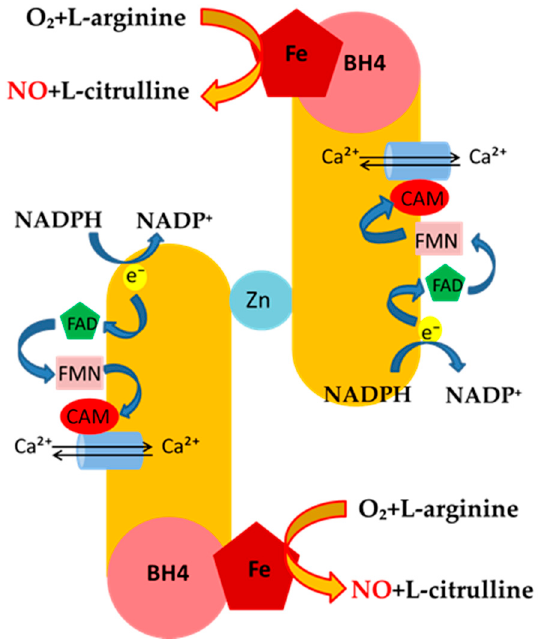
Figure 2. Mechanisms of NO-release and eNOS regulation.